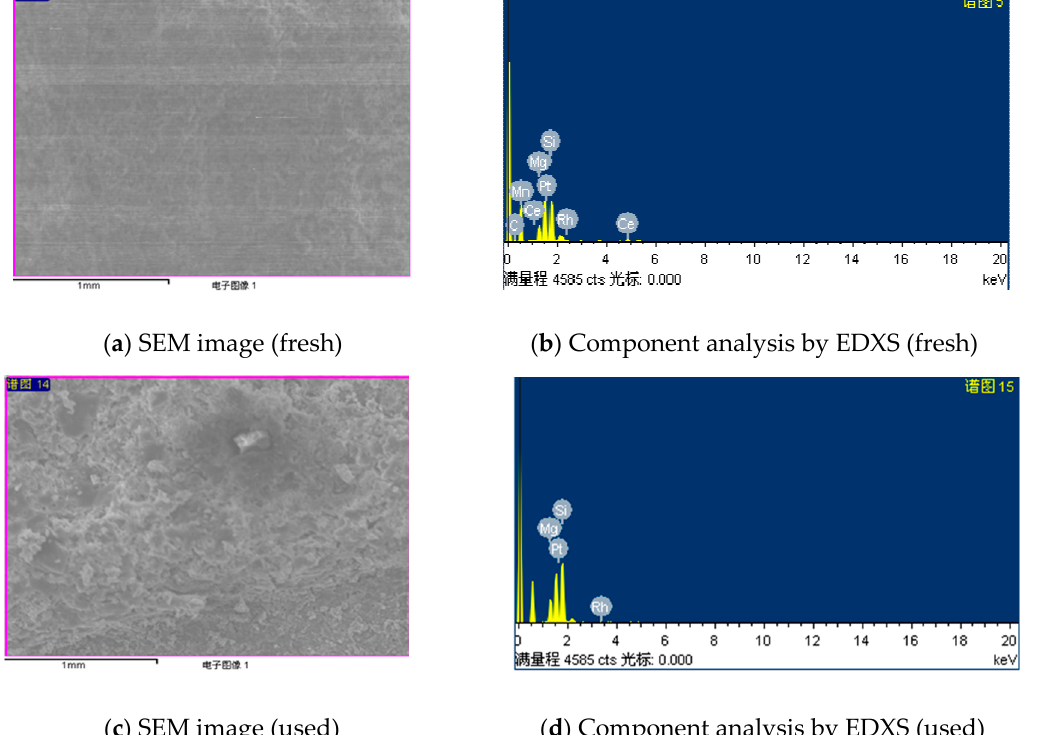
Figure 9. SEM / EDXS analysis of an advanced TWC sample (fresh and used catalysts). Figure 9. SEM/EDXS analysis of an advanced TWC sample (fresh and used catalysts). Table 2. Quantitative analysis of the composition measured by EDXS. Table 2. Quantitative analysis of the composition measured by EDXS.